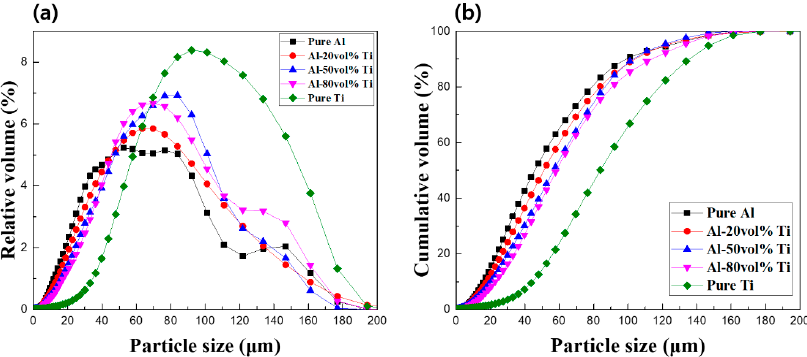
Figure 4. ( a ) Relative and ( b ) cumulative particle size distributions of the five different powders.